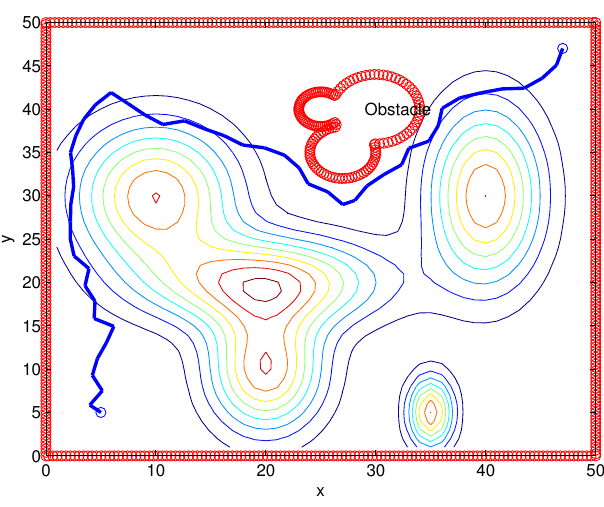
Figure 6. One route constructed under one MC simulation of the RRT ∗ (Scenario 1). The generated route is shown with blue line segments.